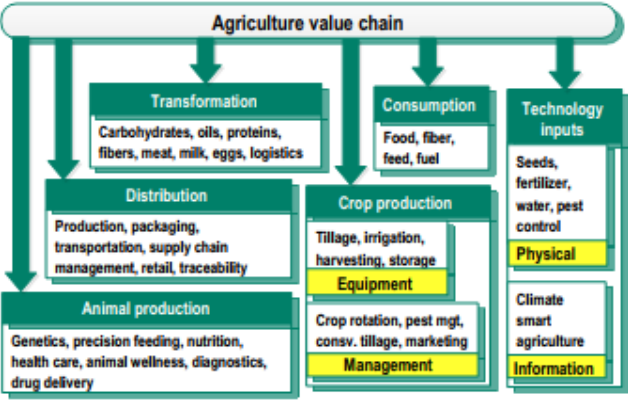
Figure 11. Agriculture value chain